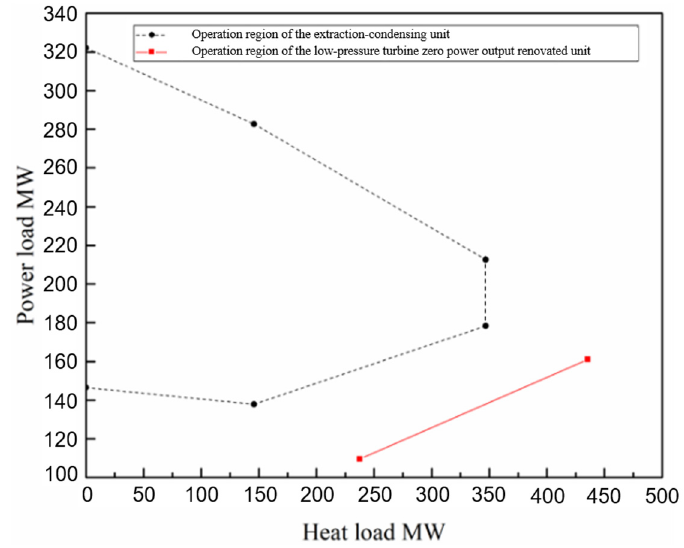
Figure 8. Operation region of #3 unit.